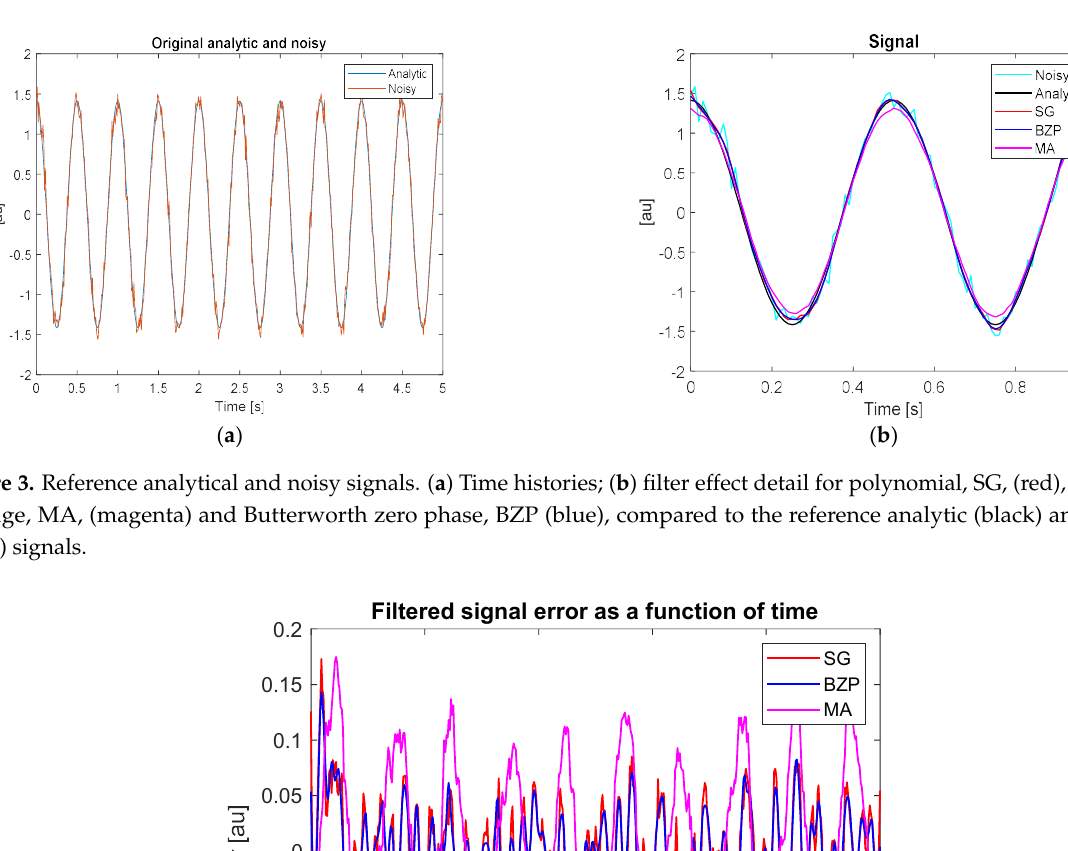
Figure 3. Reference analytical and noisy signals. ( a ) Time histories; ( b ) filter effect detail for polynomial, SG, (red), moving average, MA, (magenta) and Butterworth zero phase, BZP (blue), compared to the reference analytic (black) and noisy (cyan) signals.